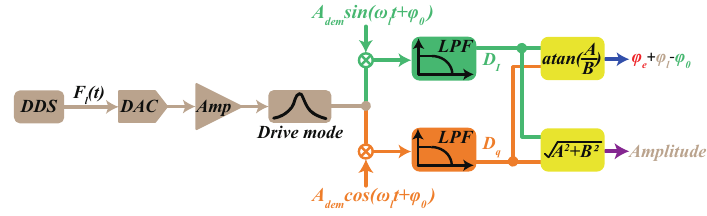
Figure 4. The sketch for quantization of the phase delay